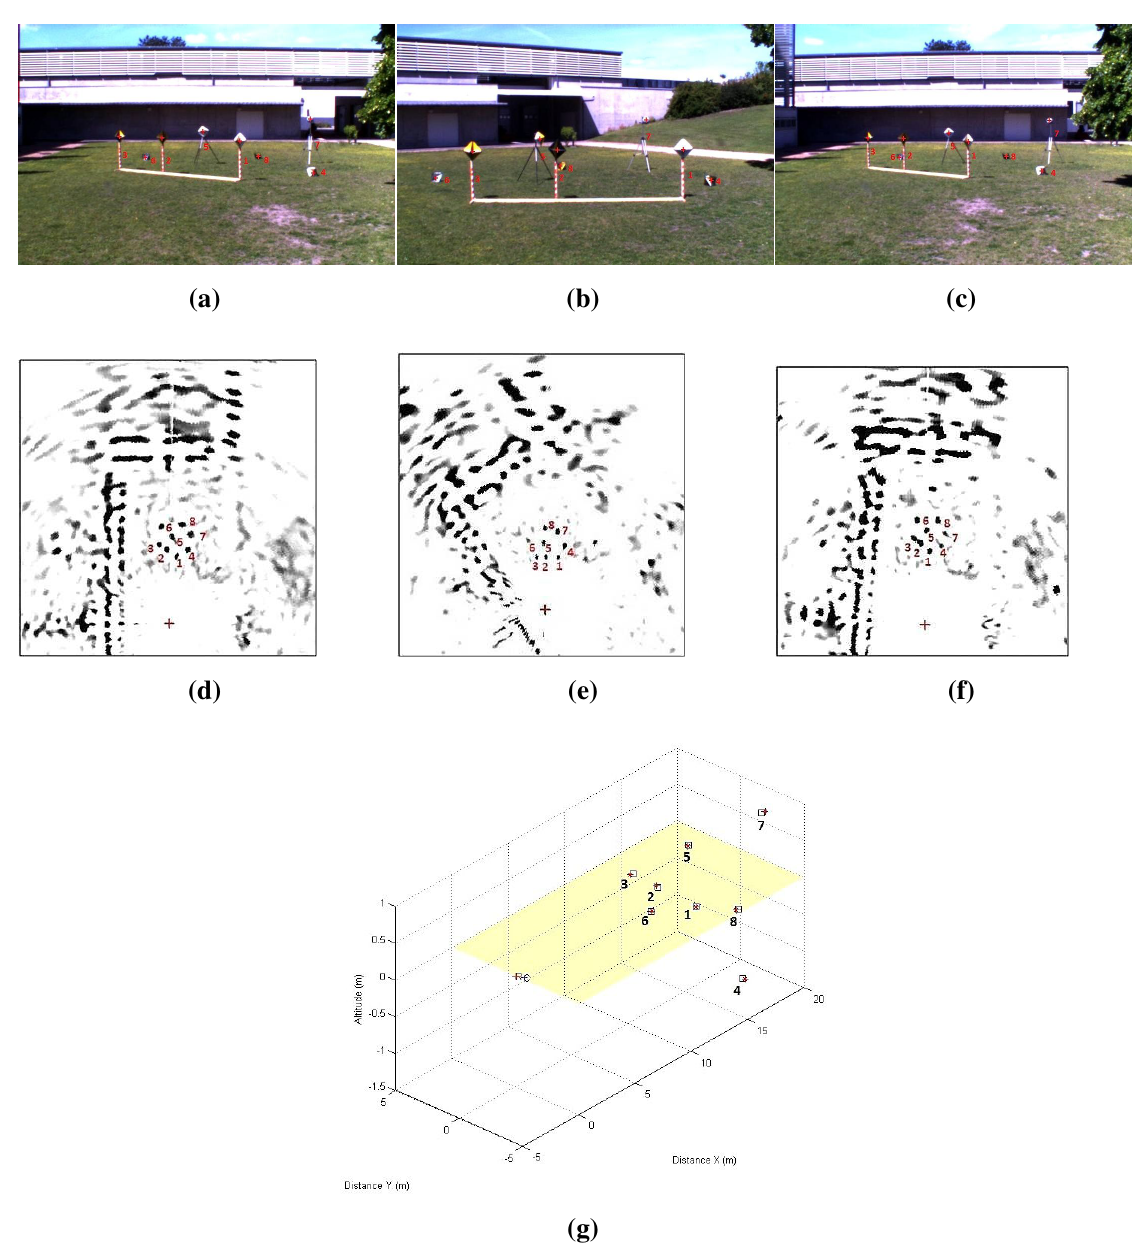
Figure 21. Top line: Camera images of the eight canonical targets. middle line: Radar images with eight canonical targets. The reconstruction results from both our reconstruction methods (circular points) and the stereo head method as the ground truth (squared points). The radar position is indicated by the letter R. ( a ) First position; ( b ) Second position; ( c ) Third position; ( d ) First position; ( e ) Second position; ( f ) Third position; ( g ) Reconstruction